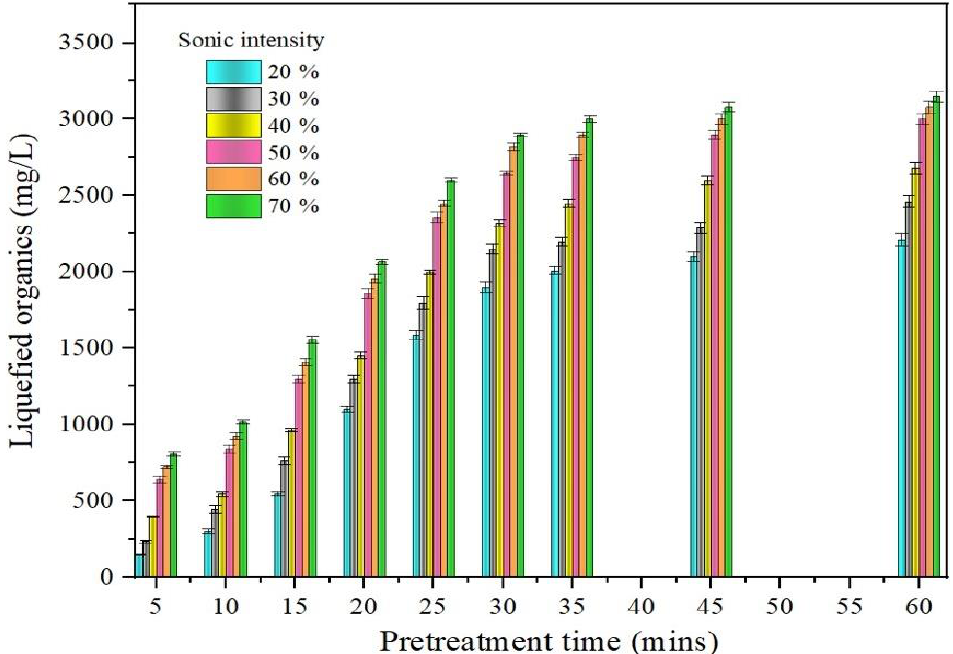
Figure 1. Impact of SL on LOR.